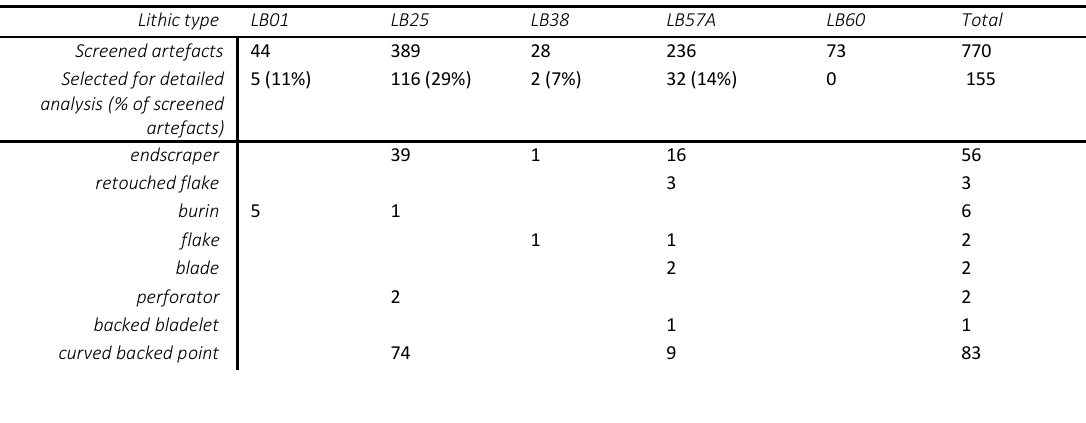
Table 3. Lithics selected for detailed functional